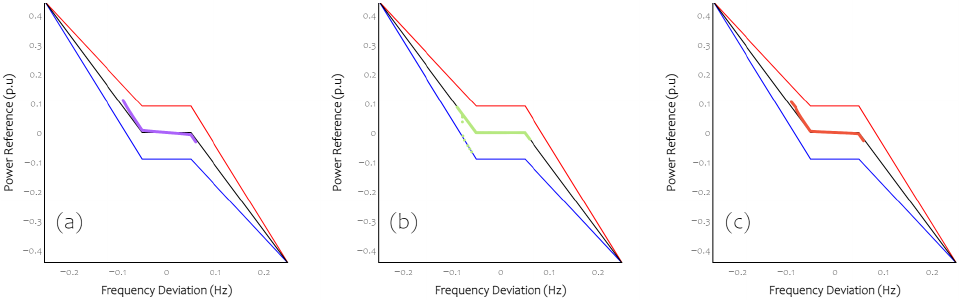
Figure 5. Controller performance on working days of ( a ) conventional FLC, ( b ) PID controller, and ( c ) Type-2